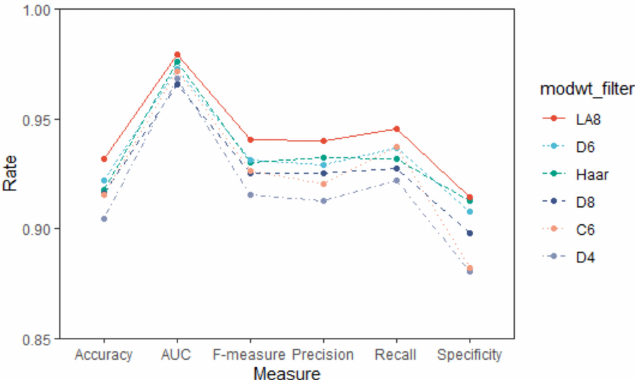
Figure 2. AD vs. NC discriminant results of the six wavelet filters based on LDA (mean